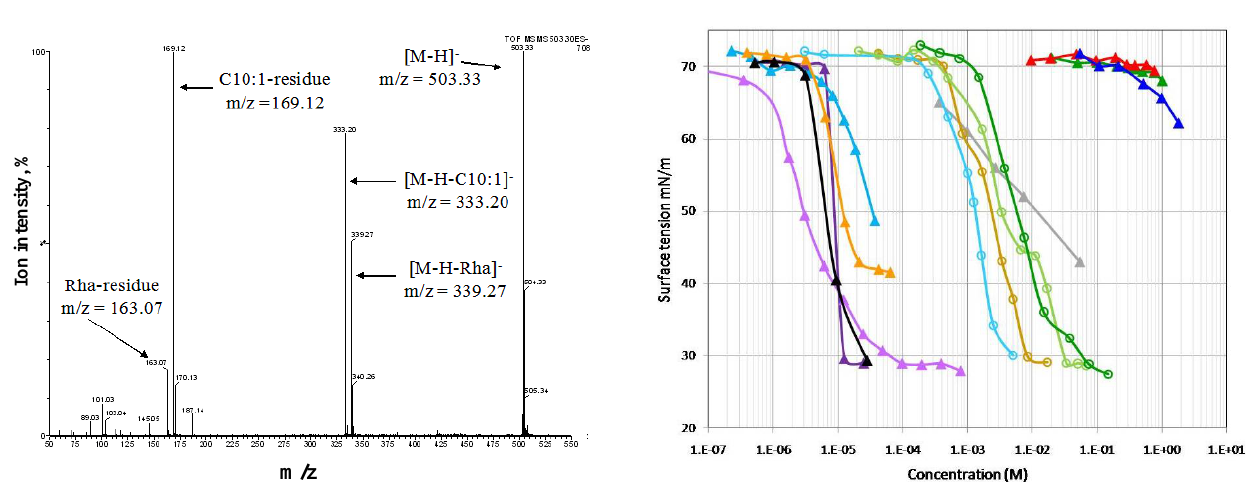
Fig. 1. MSMS spectrum of the reference rhamnolipid JBR425 (Mw: 504.330) in negative ion mode: Parent ion ( m/z =503.33), fragment ions of the rhamnose moiety, “Rha-residue” ( m/z =163.07), and of the fatty acid moiety “C10:1-residue”, ( m/z =169.12).